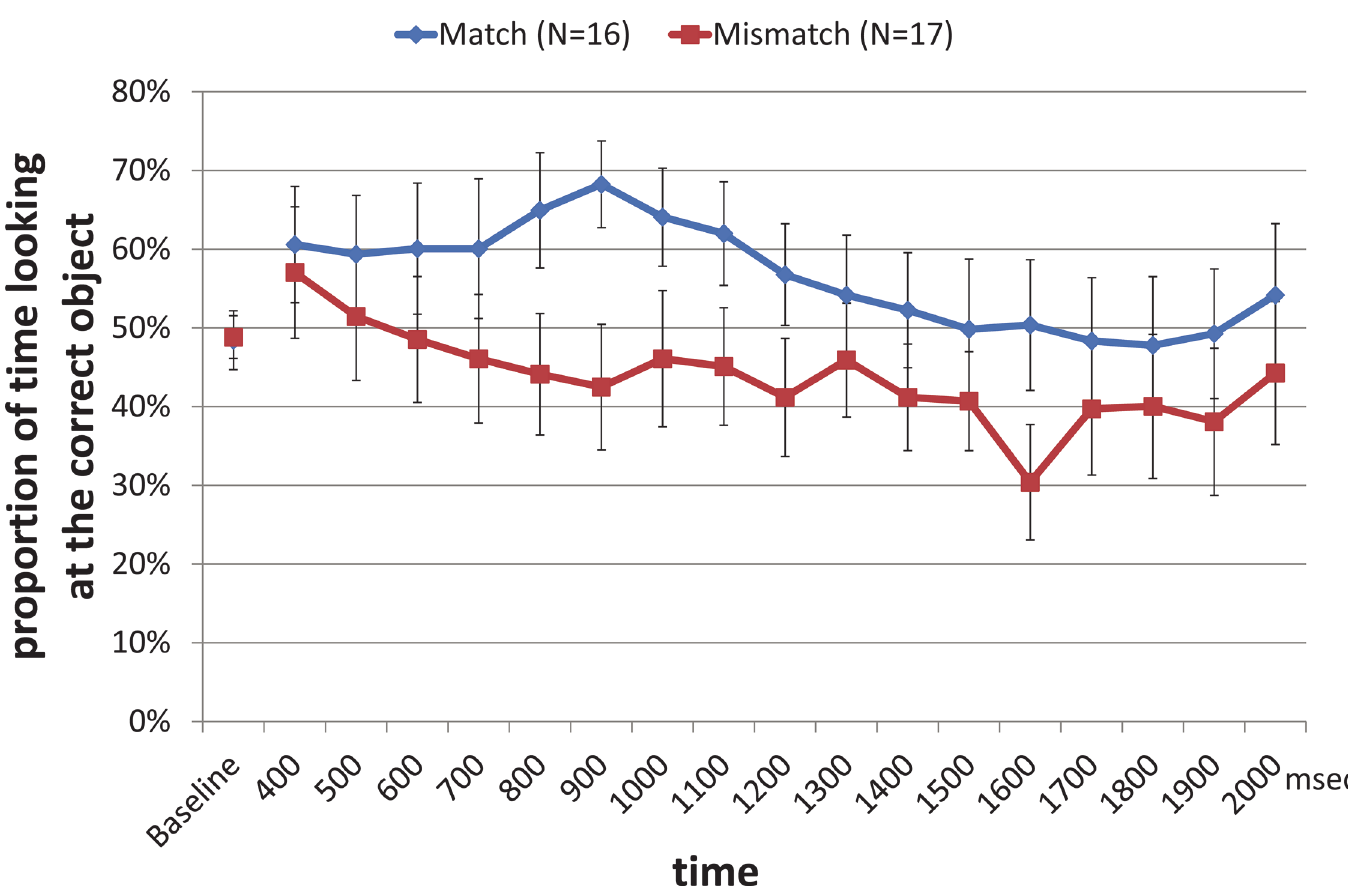
Fig 3. Mean proportion of time looking at the correct target object in 100 ms intervals in the test trials. Baseline looking was calculated by averaging infants ’ looking at the target object 3000 ms immediately prior to the word onset. The error bar indicates standard error.